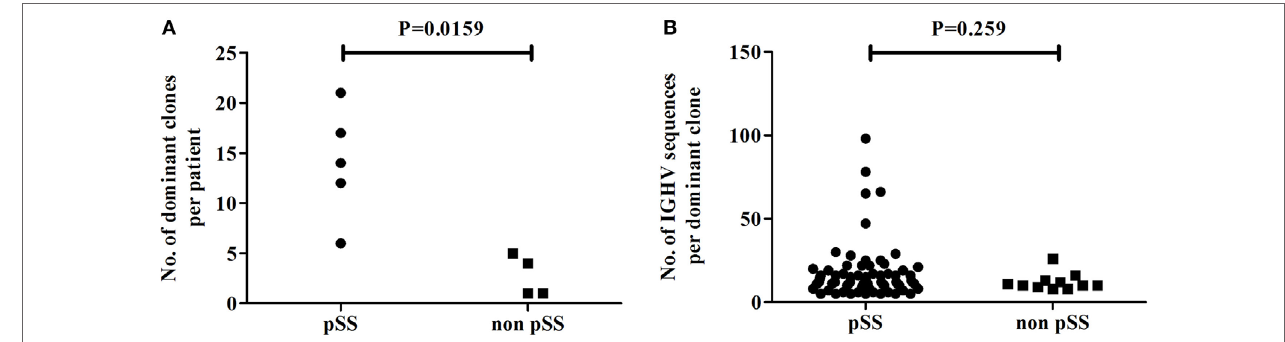
FigUre 3 | Clonal expansion of Ig-producing cells in the biopsies of the parotid salivary gland of pSS patients and non-pSS sicca controls. (a) Number of dominant clones present in the parotid gland per patient. (B) Number of IGHV sequences per dominant